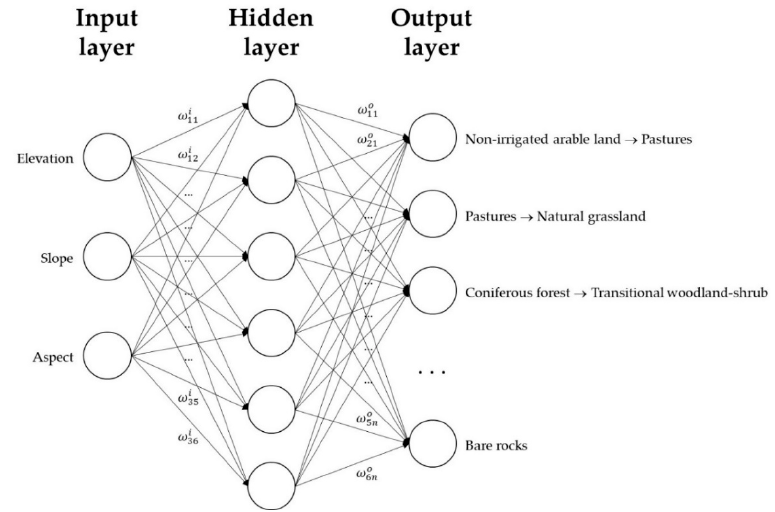
Figure 3. Multi-layer perceptron neural network used for generating future land cover scenarios.